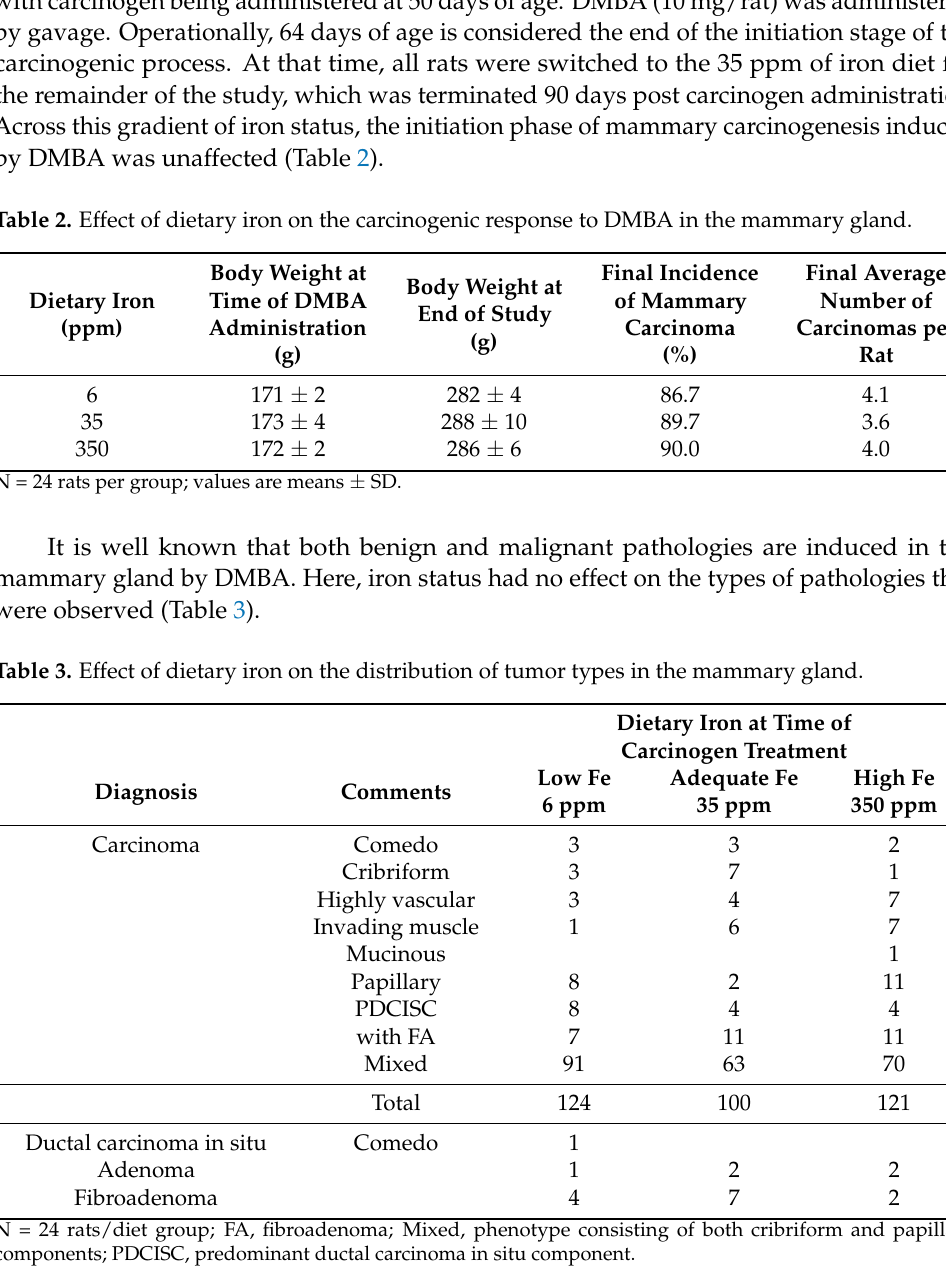
Table 2. Effect of dietary iron on the carcinogenic response to DMBA in the mammary gland. Body Weight at Body Weight at Time of DMBA Dietary Iron (ppm) (g)